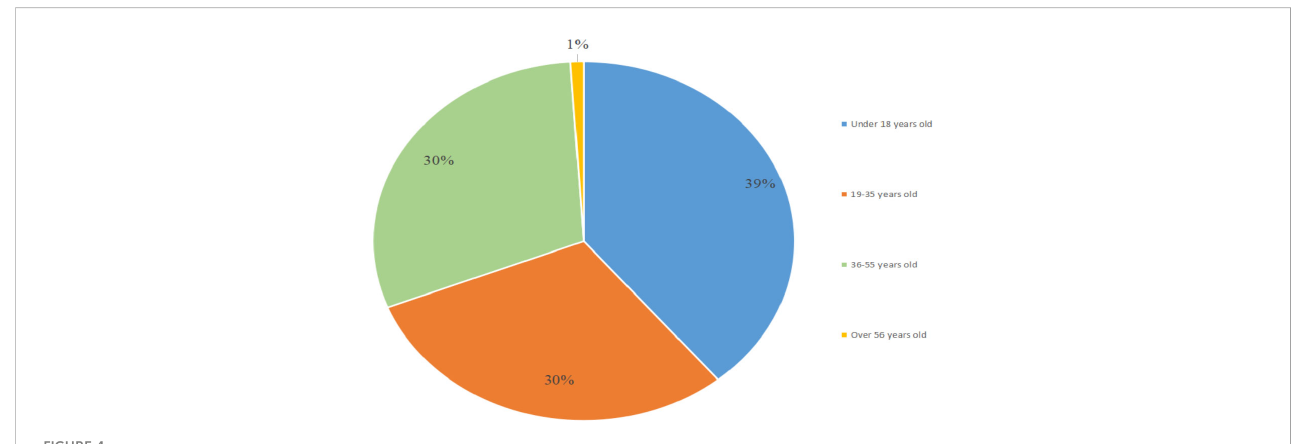
FIGURE 4 Age distribution of 23 reported